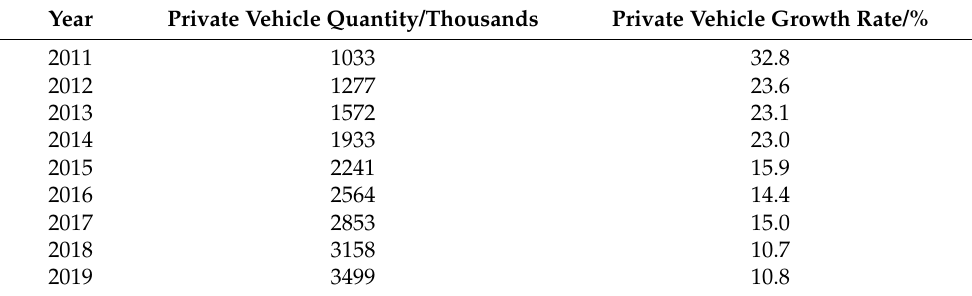
Table 2. Private vehicle quantities and growth rates in a city in China.